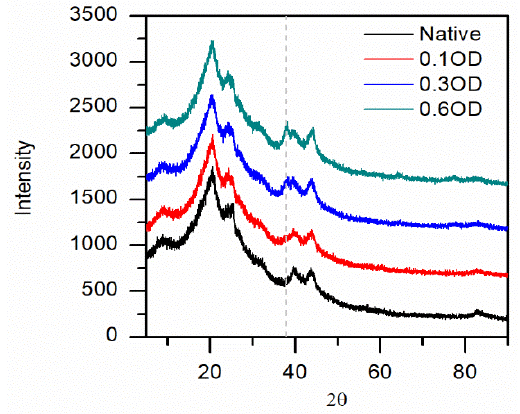
Figure 10. Intensities versus diffraction angle (2 θ ) as derived by our X-ray diffraction for silk fibers with different amounts of gold. For three times and six times gold addition, the gold peaks were at 2 θ = 38 ◦ , 65 ◦ and 78 ◦ . No gold was detected for one-time gold addition. The silk characteristic peaks were at 20 ◦ , 25 ◦ , 40 ◦ and 42 ◦ . The grey dotted line indicates the gold reflection at 38 ◦ .